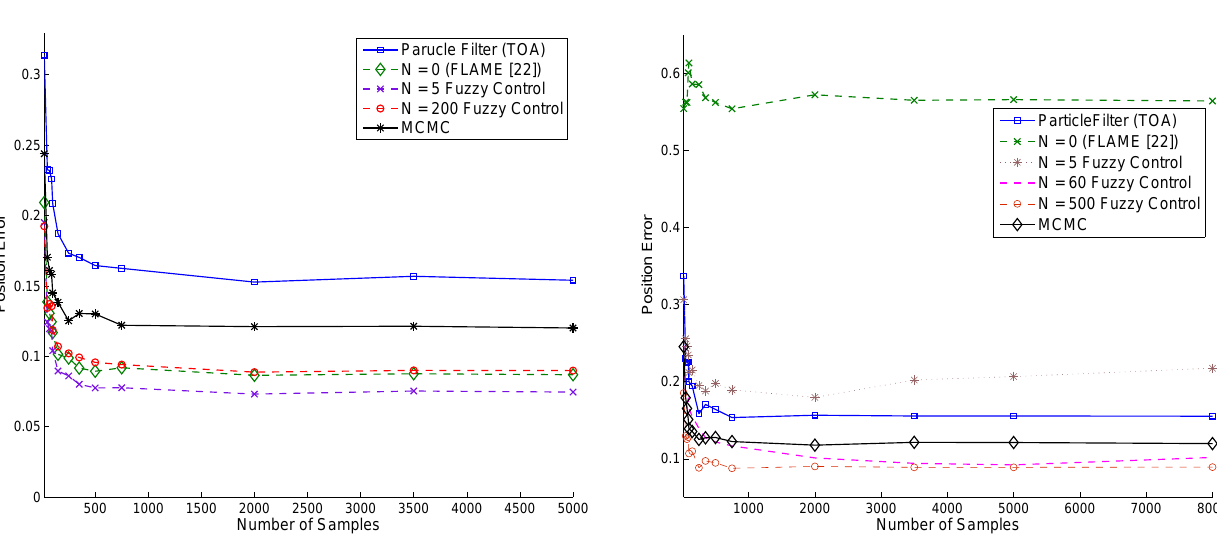
Figure 17. Performance comparison of the ATPA and the FLAME algorithms.